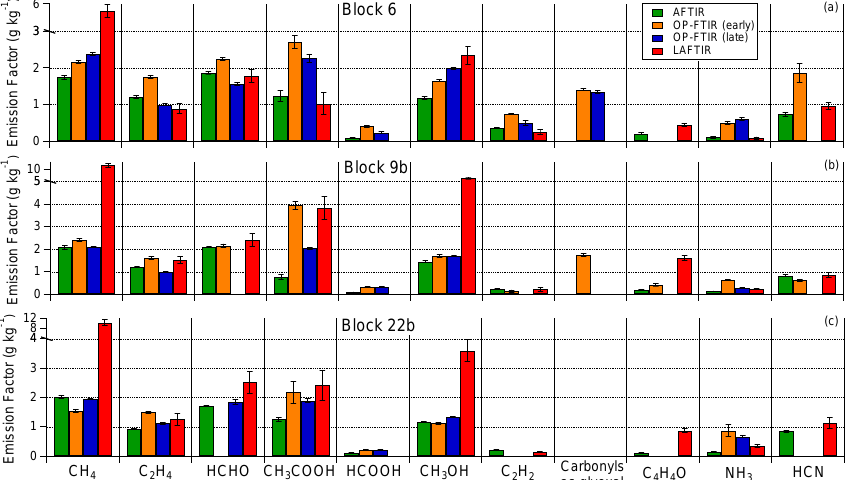
Fig. 6. Emission factors (gkg − 1 ) measured by the AFTIR (green), OP-FTIR, and LAFTIR (red) from the three Fort Jackson fires: (a) Block 6, (b) Block 9b, and (c) Block 22b. The OP-FTIR EF have been broken down into “early” (orange) and “late” (blue) as shown in Fig. 3. Error bars represent the relative uncertainty in the EF. A break has been added in the uppermost y axis EF values that applies only to CH 4 and CH 3 OH, when applicable.